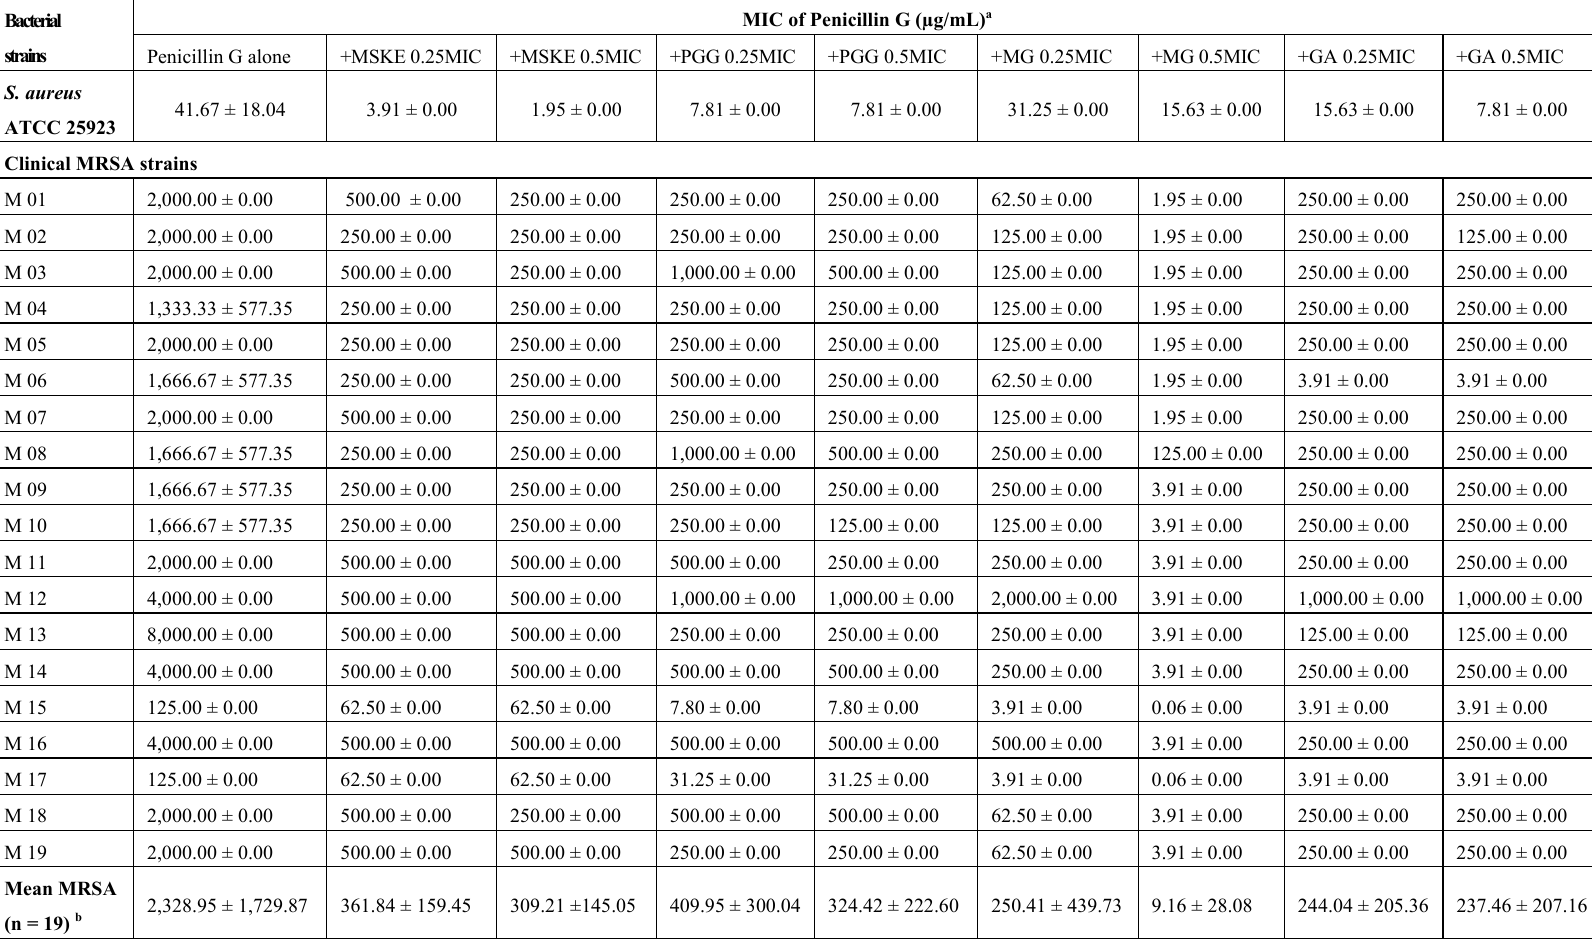
Table 3. The enhancing effects of MSKE and its phenolic principles on the antibacterial activities of penicillin G against S. aureus ATCC 25923 and 19 clinical MRSA isolates ( a mean values ± S.D. of triplicate results, b mean values ± S.D. from 19 MRSA